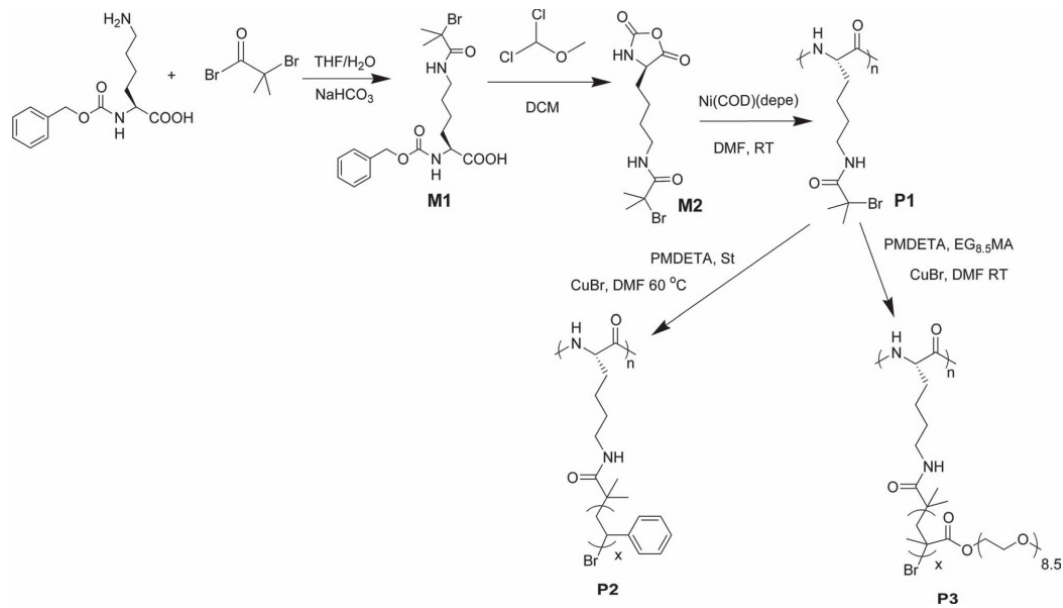
Figure 49. Synthetic route to poly(Br- L -lysine) (PBrLL) ( P1 ), PLL- g -PS ( P2 ), and PLL- g -PEGMA ( P3 ) polypeptide bottlebrushes. Reproduced with permission from reference [52].